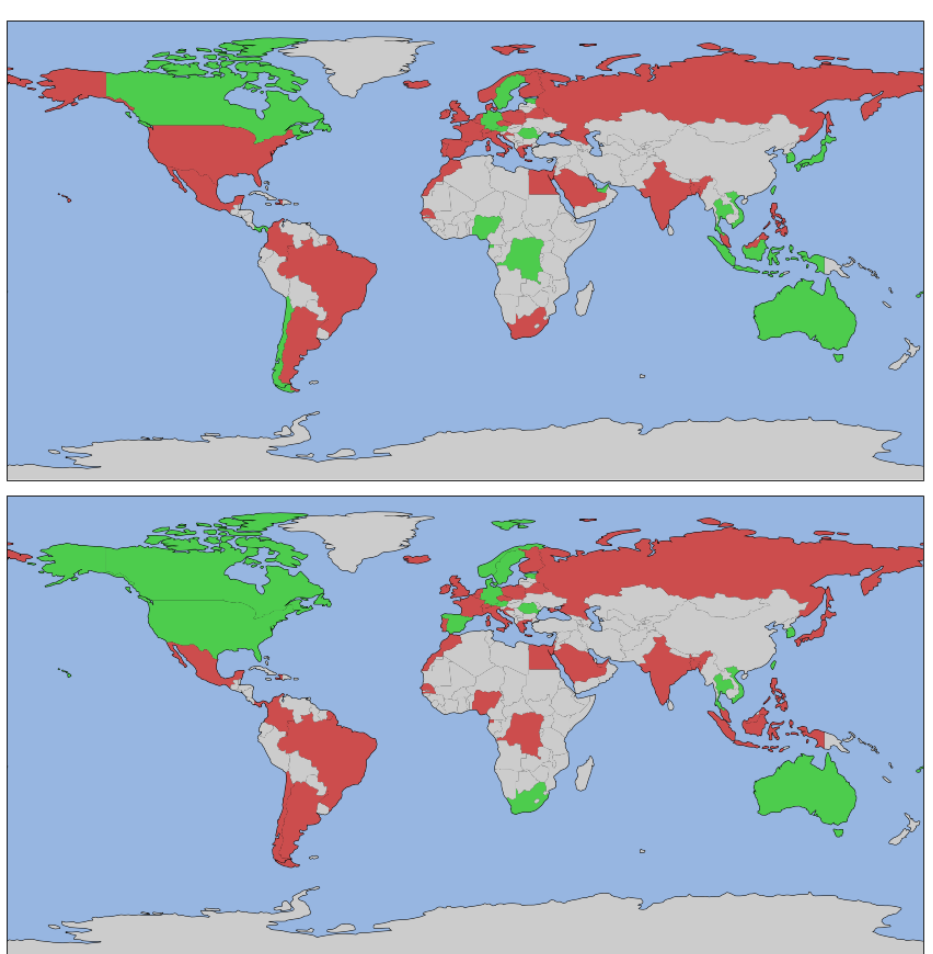
Figure 4. Countries were painted red if considered infected, green if not, and gray if the country was excluded from the analysis. Top : Daily avg. infections , Middle : Reproductive rate , Bottom : Exponential